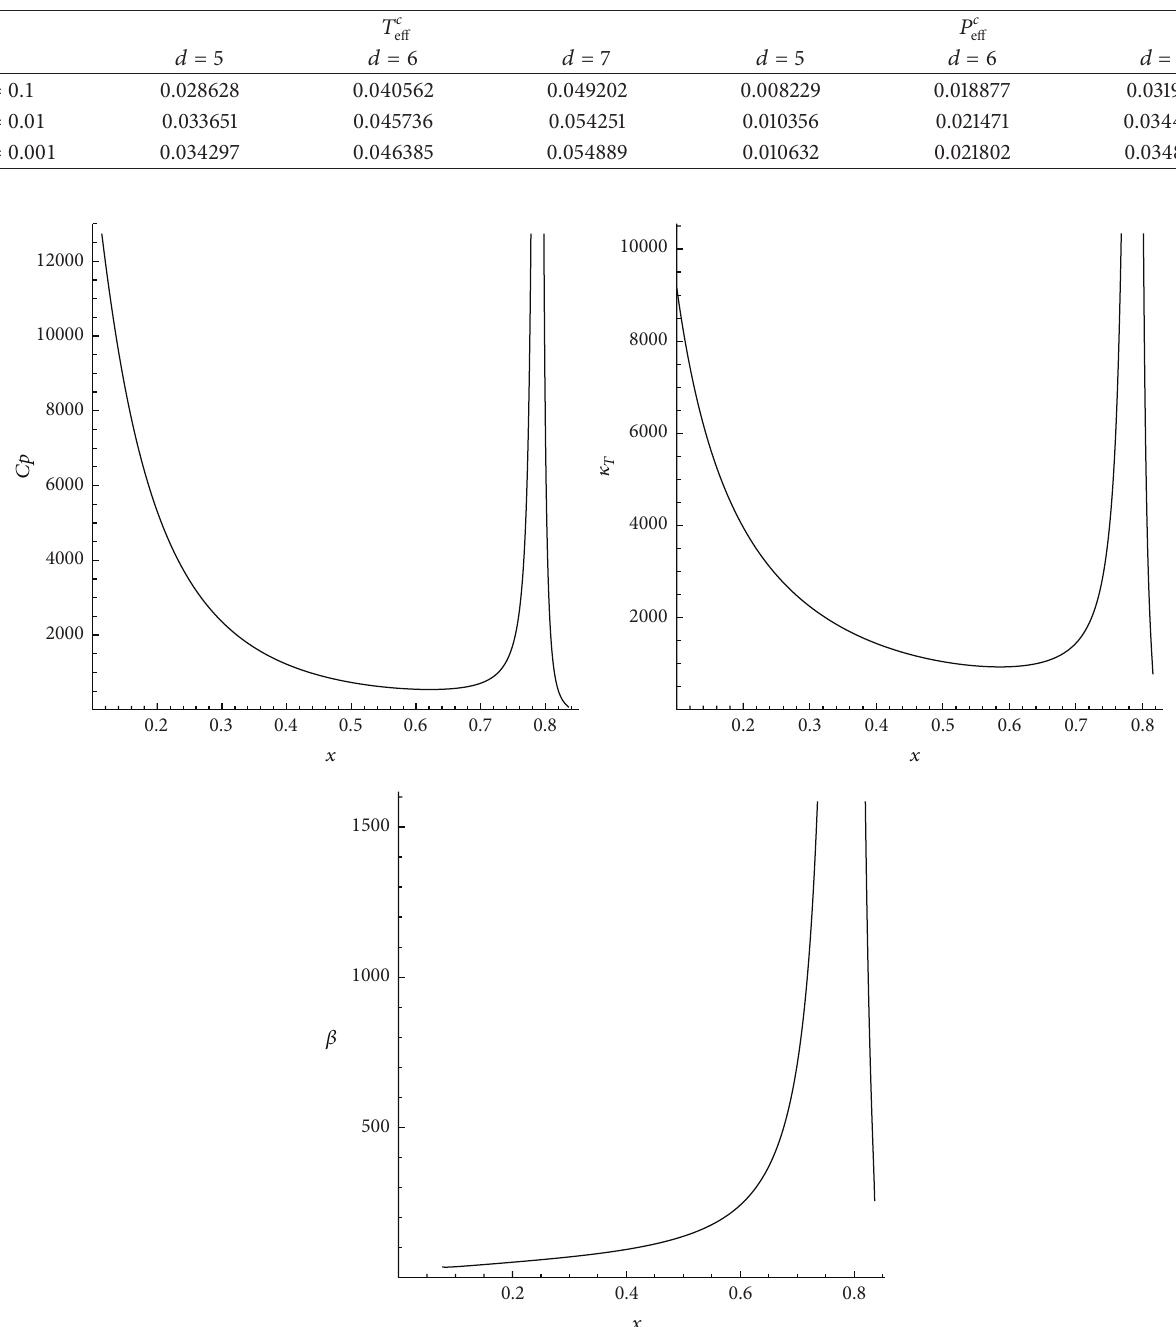
Table 1: Numerical solutions for 𝑇 𝑐 respectively.